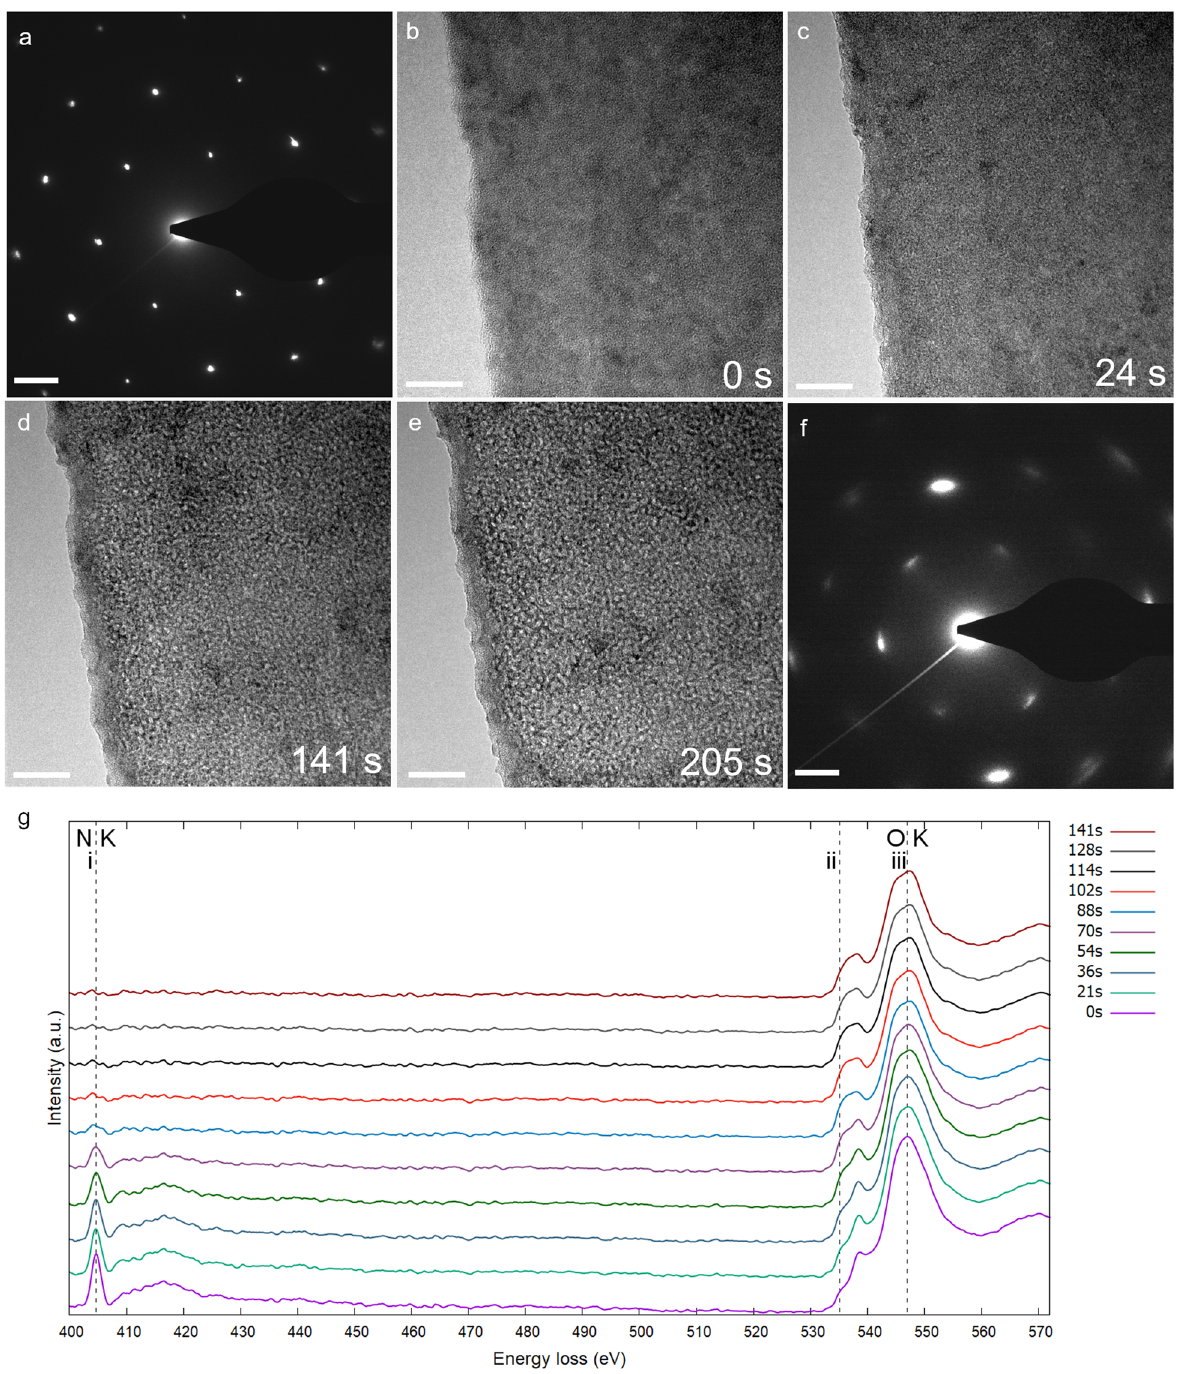
Fig. 6 Electron irradiation of Ni – Fe LDH at 80 kV. a SAED patterns of the Ni – Fe LDH before irradiation experiments. b – e Time series TEM images recorded after 0 s, 24 s, 141 s and 205 s of electron irradiation respectively. f Electron diffraction patterns of the irradiated region. g EELS spectra time series of the nitrogen and oxygen K edges recorded from the same LDH platelet from 0 to 141 s. Scale bars are 2 nm − 1 for the SAED patterns and 20 nm for the BFTEM micrographs